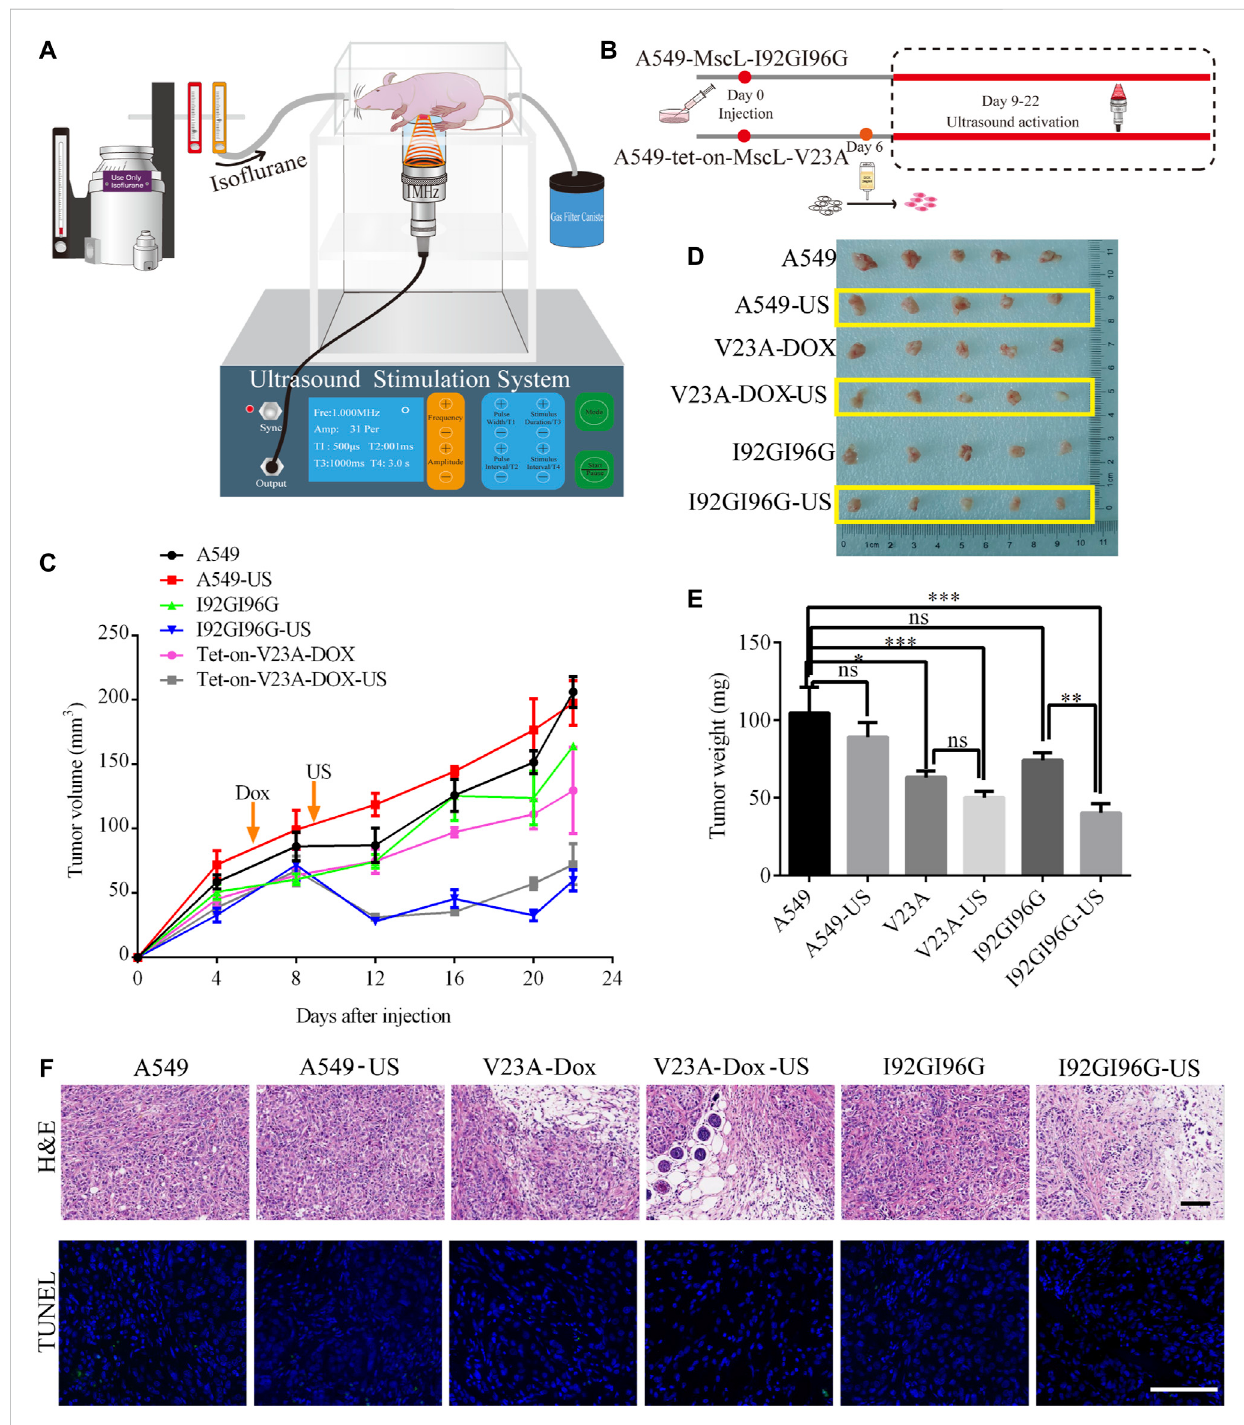
LIFUinhibitsA549tumorgrowththroughactivatingMscL. (A) Schematicillustrationoftheexperimentalset-upforultrasoundBALB/cnudemice. (B) Schematic diagram of A549 xenograft in BALB/c nude mice. (C) Summary of tumor growth of different mouse groups (mean ± SEM, n = 5). (D) Mass of tumor samples after 22 days of transplantation. (E) Summary of tumor weight following sacri fi ce of mice (mean ± SEM, n = 5, * p < 0.05, *** p < 0.001, ns: no signi fi cance). (F) Representative areas of H&E and TUNEL staining of tumor tissue. Scale bars: 50 µm.